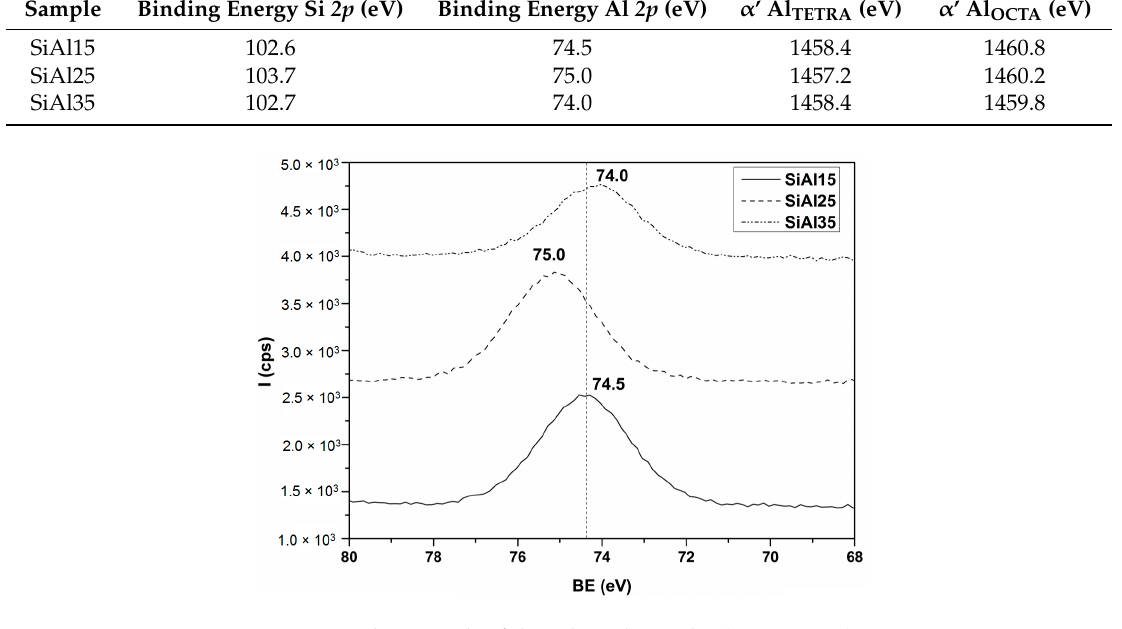
Figure 5. Al 2p signals of the calcined samples (XPS spectra).